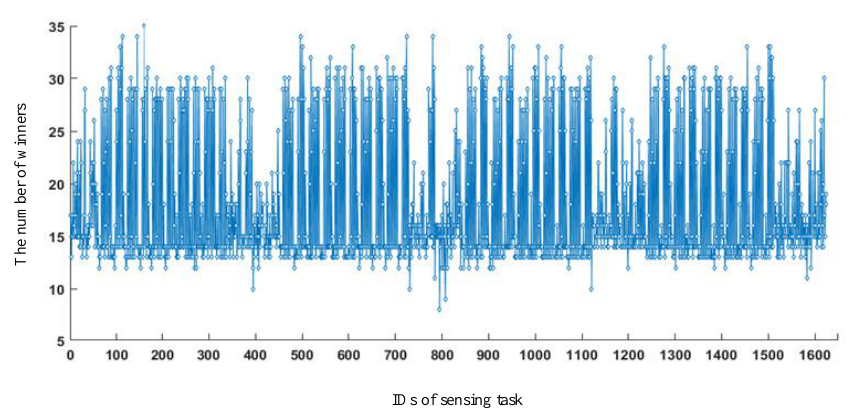
Figure 14. The number of winners for all sensing tasks.